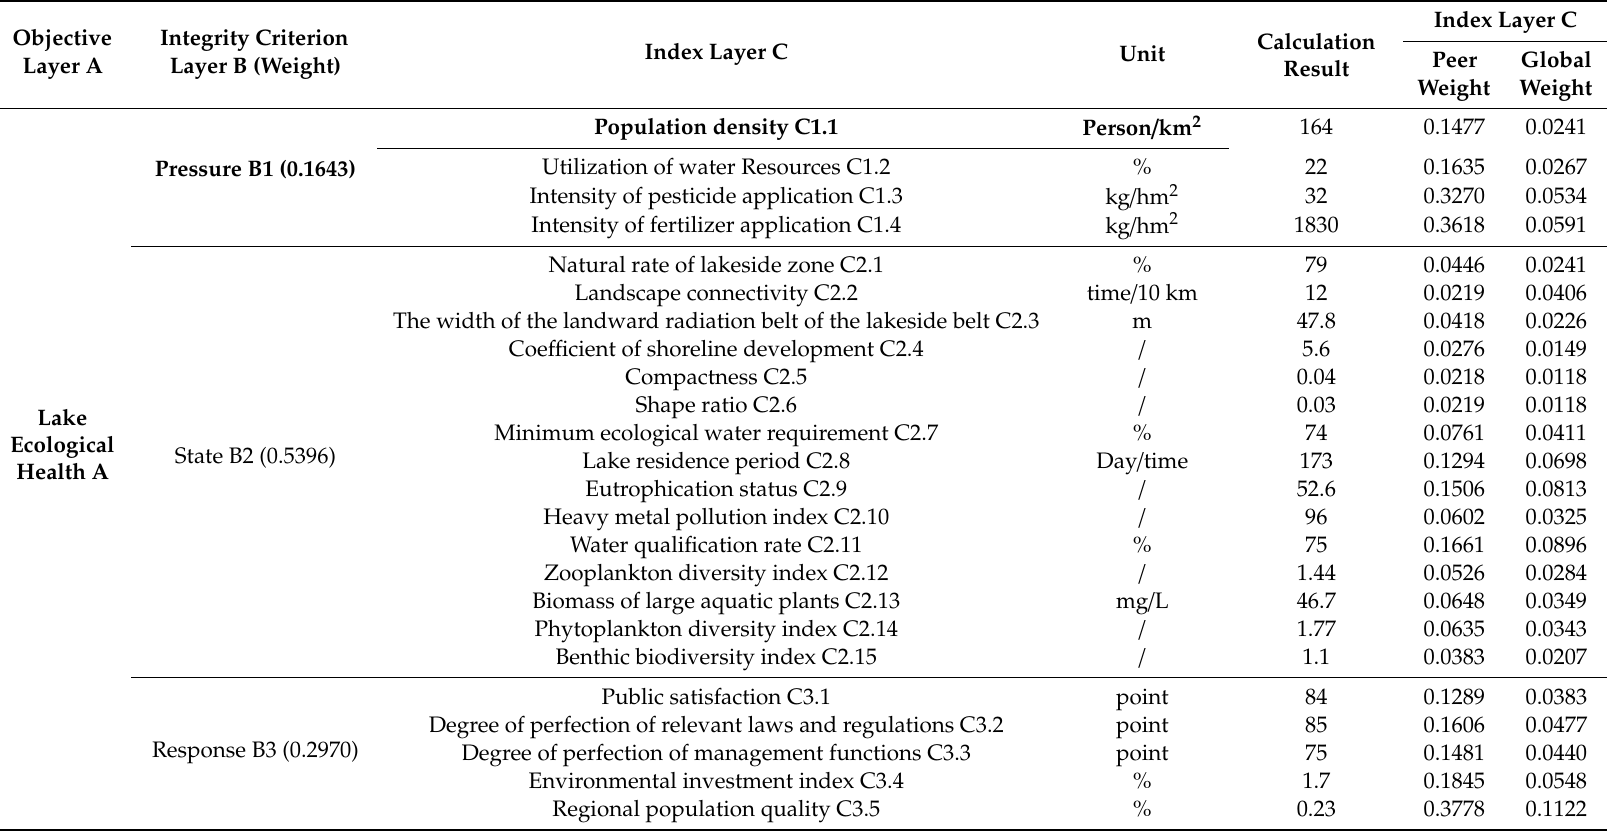
Table 1. Health quality evaluation system for urban